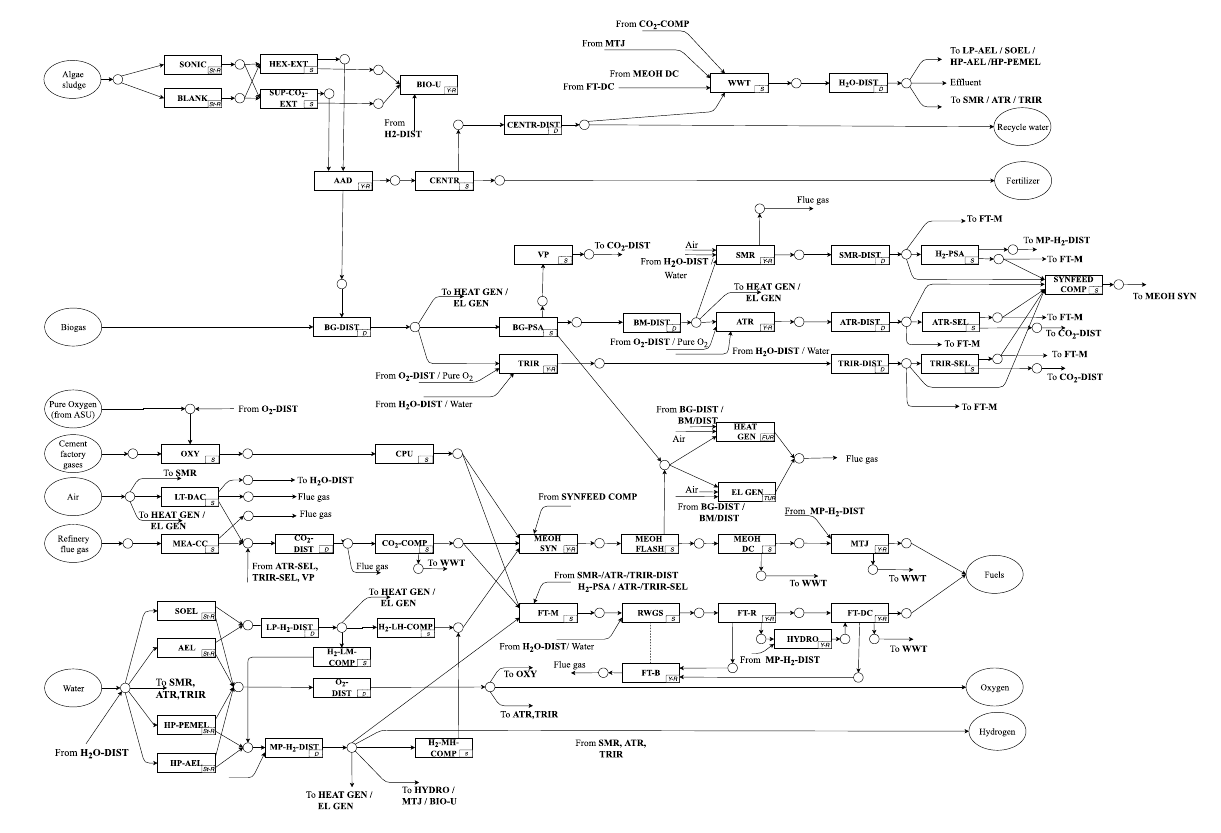
Figure A1. Superstructure representation of renewable refinery for fuels production.